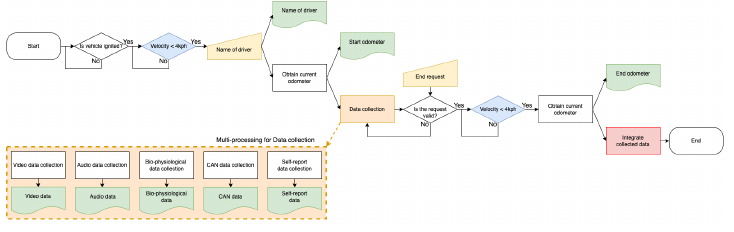
Figure 3. Flow chart of the proposed data collection system during real-world